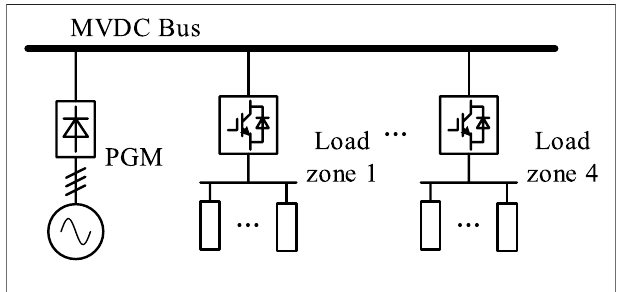
FIGURE 1 | MVDC distribution system network.